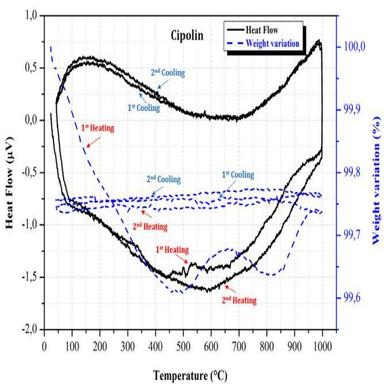
Mass loss and heat flow variation during two thermal cycles for Cipolin rock.